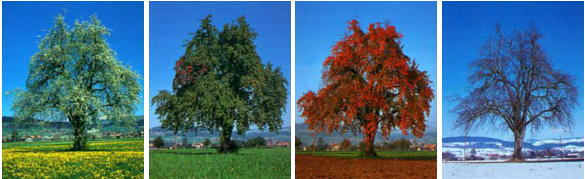
Figure 2: Seasonal variations of a pear